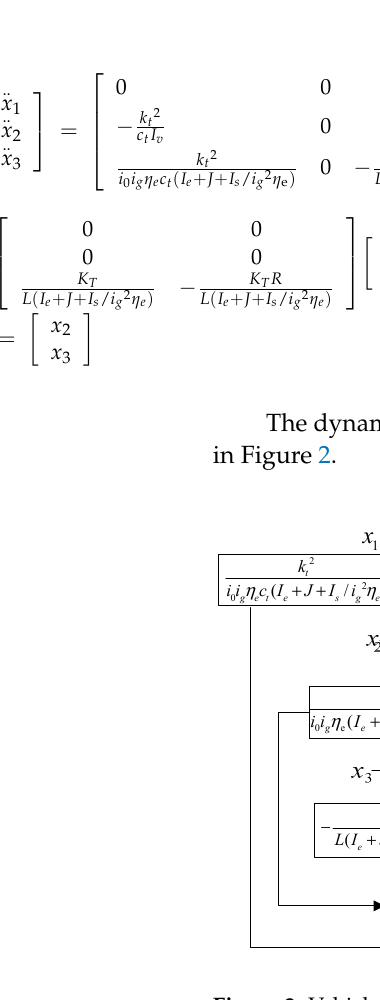
Figure 2. Vehicle model diagram of the system.